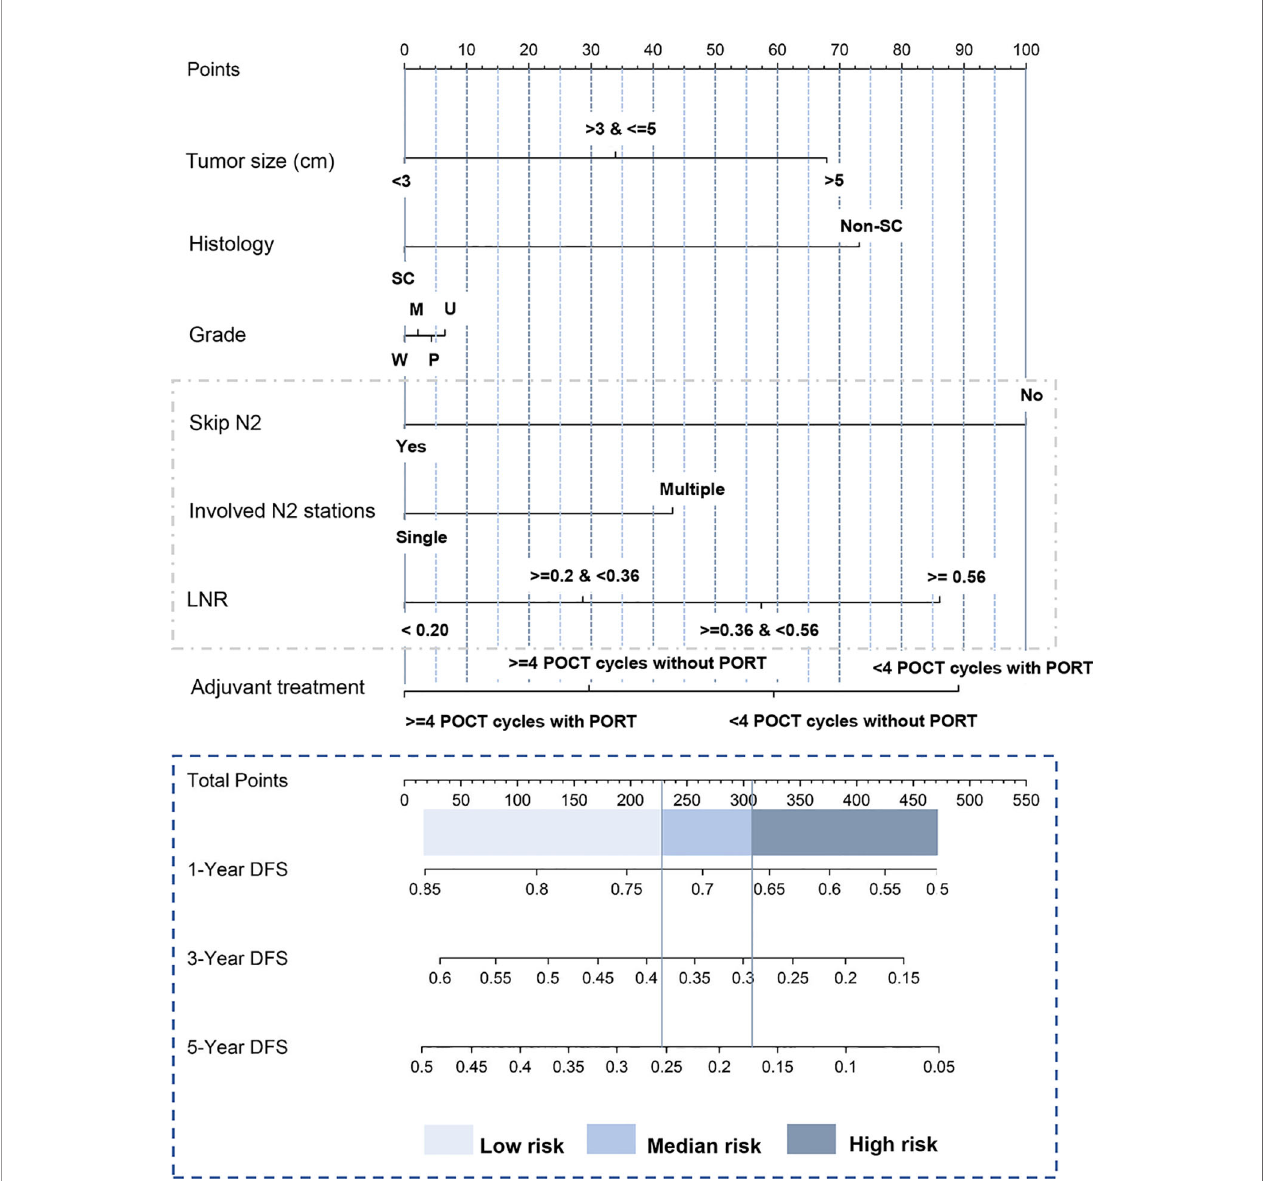
FIGURE 1 | Nomogram predicting postoperative DFS of patients with pathologic N2 non-small cell lung cancer. The tertile of the risk points of patients in the training set was de fi ned as the cutoff value. All patients were divided into three subgroups, named low-risk group (risk point: 0 – 226), median-risk group (risk point: 226 – 306), and high-risk group (risk point: 306 – 466). Supplementary File 1 provides detailed information for the nomogram usage. SC, squamous carcinoma; Non-SC, non-squamous non-small-cell lung cancer; W, well-differentiated; M, moderately differentiated; P, poorly differentiated; U, undifferentiated; LNR, lymph